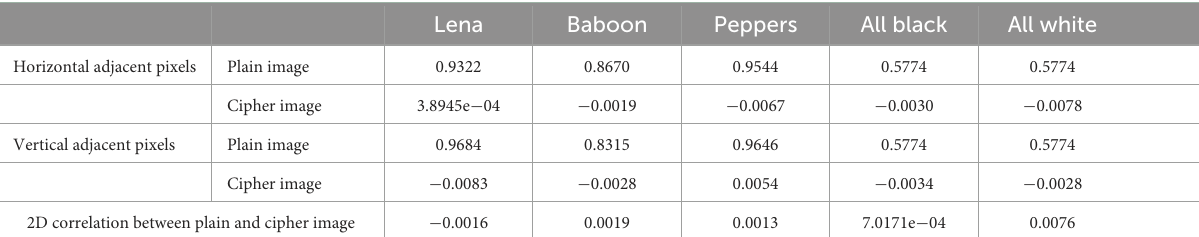
Vertical adjacent pixels